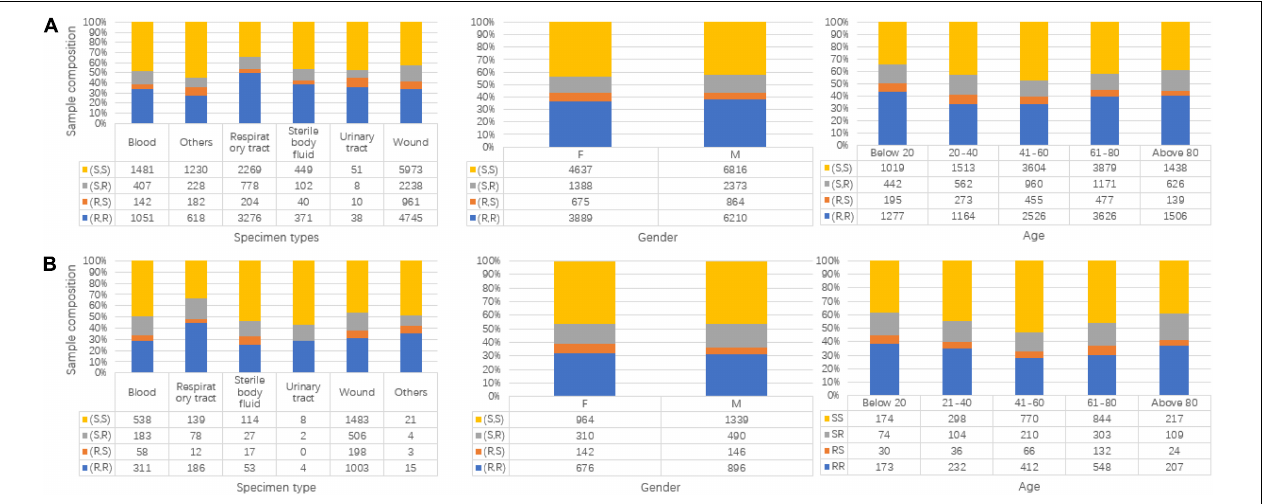
FIGURE 2 | Data composition information in isolated Staphylococcus aureus for Linkou cohort in subgraph (A) (discovery population) and Kaohsiung cohort in (B) (replication population). The turtle in the graph stands for clindamycin susceptibility and oxacillin susceptibility. R is for resistant, and S is for susceptible. (A) Specimen types, gender, and age map to multi-labels in the discovery population. (B) Specimen types, gender, and age map to multi-labels in replication